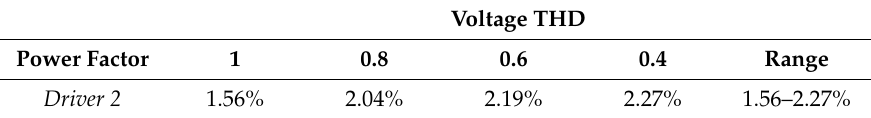
Figure 15. Driver 2 example of practical conduction delay response for ohmic load. For the used SCR, this conduction delay has been recorded by laboratory test assuming a resistive load. Red circles show the distortion at the zero-cross of the voltage. Table 6. THD of the load voltage obtained adopting constant gate pulse strategy in Driver 2.